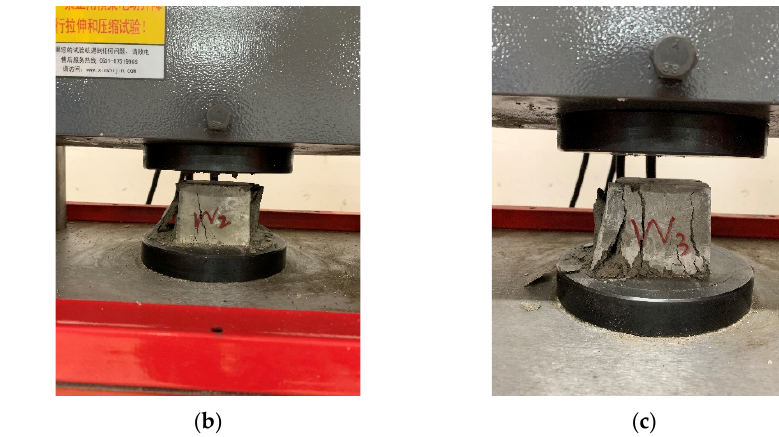
Figure 11. Sample destruction. ( a ) W 1 test block destruction. ( b ) W 2 test block destruction. ( c ) W 3 test block destruction.